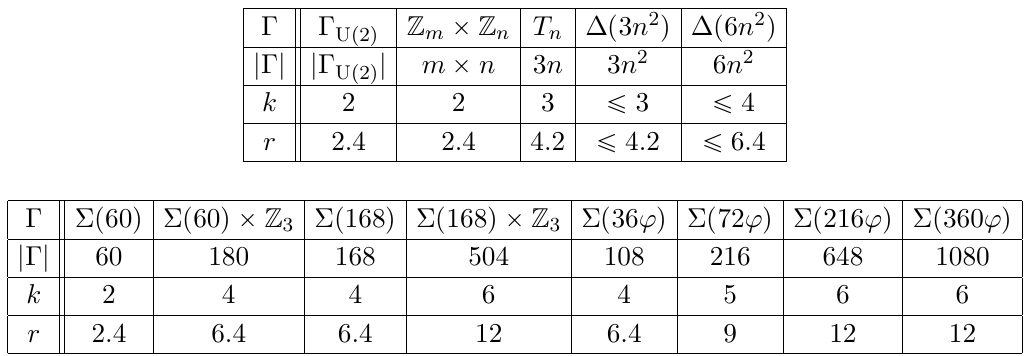
Table 2. Orbifolds of S 5 { Γ for finite groups Γ (cid:128) SU p 3 q of order | Γ | , listed with their corresponding relative order of scale separation r , and the lowest degree k for which there is a Γ -invariant spherical harmonic on S 5 . The explicit form of the invariants is given in section 4. All of these orbifolds admit Killing spinors; only the T , Z orbifolds are n n